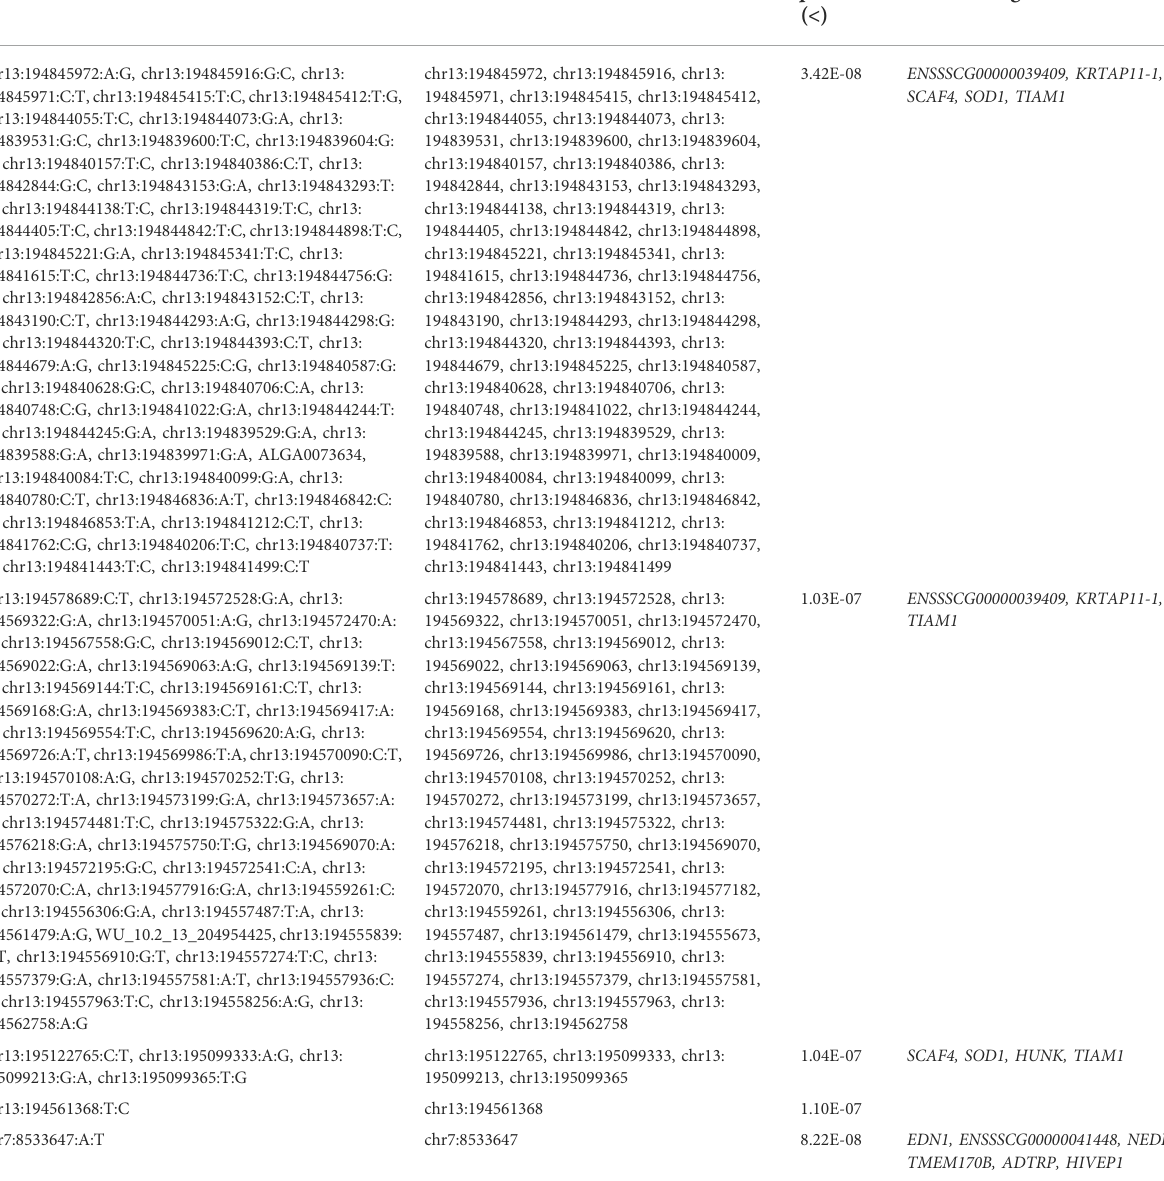
TABLE 2 The signi fi cant SNPs identi fi ed by GWAS analysis of imputed SNPs.